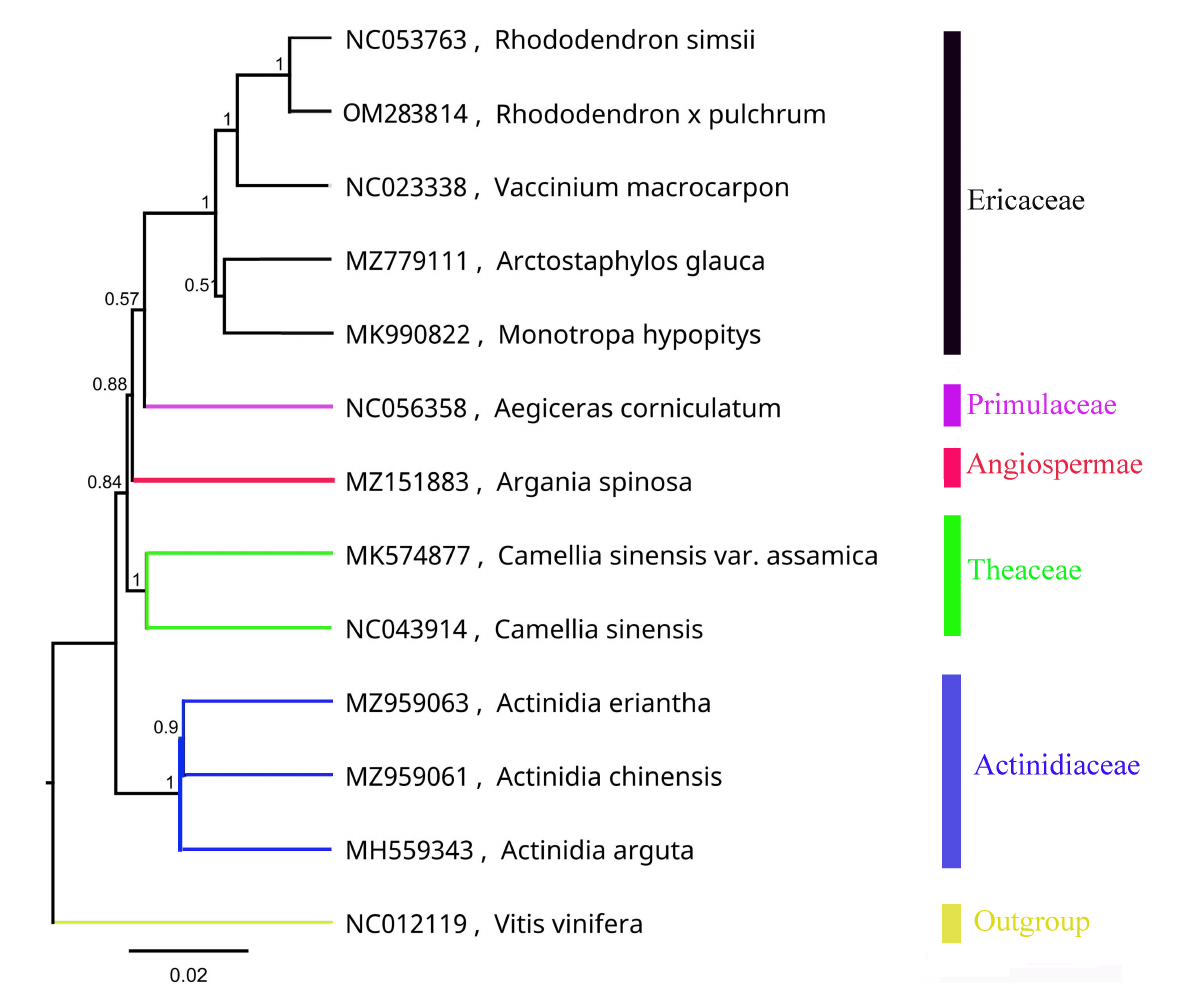
FIGURE2 Phylogenetic tree of Ericales species based on mitochondrial genomes. Vitis vinifera (NC012119) was used as the